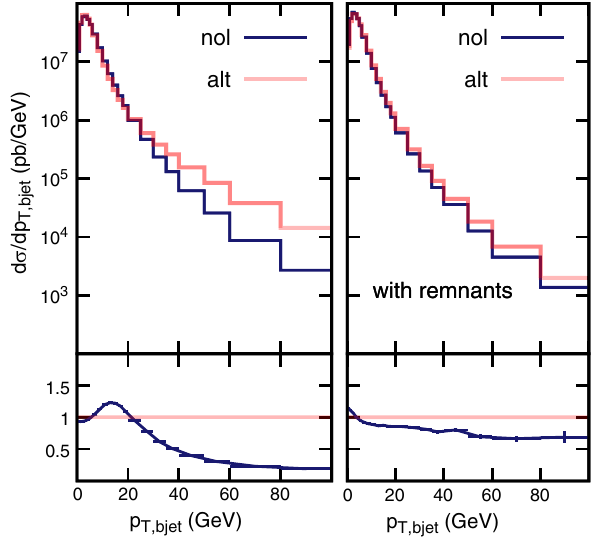
Fig. 12 Same as in Fig. 11 for the p T of the b -jet